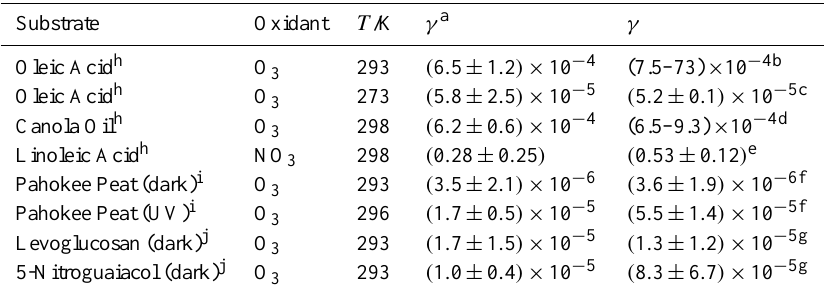
Table 1. Comparison of reactive uptake coefficients, γ , determined in this study with literature values for various liquid and solid organic substrates and gas phase oxidants. Uncertainty is ± 1 σ . Substrate